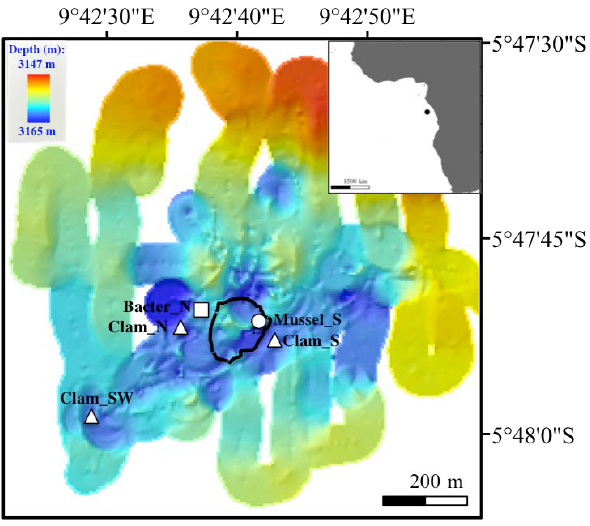
Fig. 1. Map of the REGAB pockmark (adopted from Ondr´eas et al., 2005), derived from ROV Victor 6000 data (Ifremer, France), with the main sampling locations, i.e. Bacter N, Clam N, Mussel S, Clam S and Clam SW. The black line indicates the approximate extension of carbonates with associated mytilids and siboglinids. The investigated bacterial mat is depicted with a square, the various clam patches with triangles and the mussels with a circle symbol.